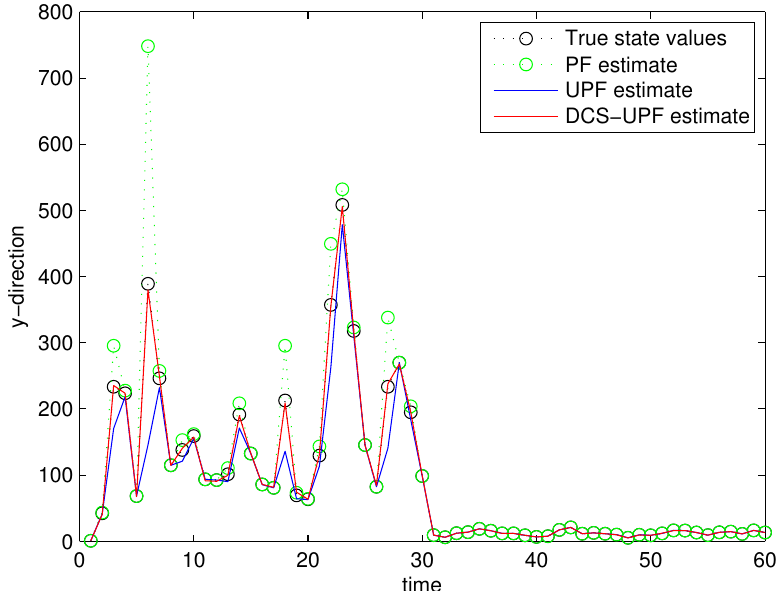
Figure 9. Target estimation in Y-direction by changing R and Q.